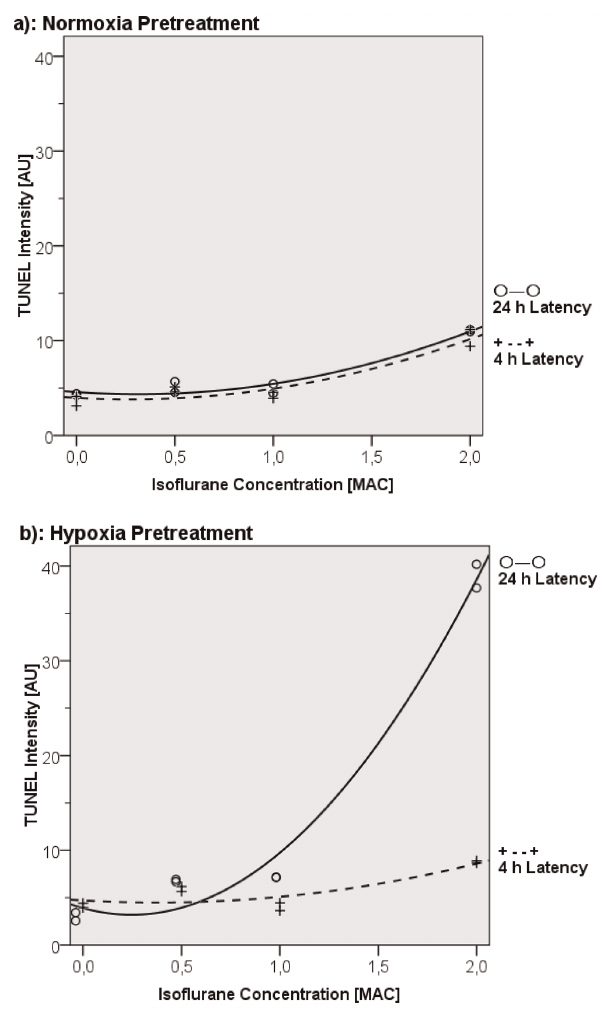
Figure 2. TUNEL Regression Analysis. Quantification and quadratic regression analysis of TUNEL fluorescence in relation to hypoxia, isoflurane concentrations, and delay to analysis subsequent to 2 hours of isoflurane exposure. a) No hypoxia. 4-hour latency period: R 2 =0.91, P=0.003; 24-hour latency period: R 2 =0.95, P , 0.001. b) Hypoxia for 24 hours followed by 2 hours of reoxygenation prior to isoflurane treatment. 4-hour latency period: R 2 =0.75, P=0.031; 24-hour latency period: R 2 =0.98, P ,